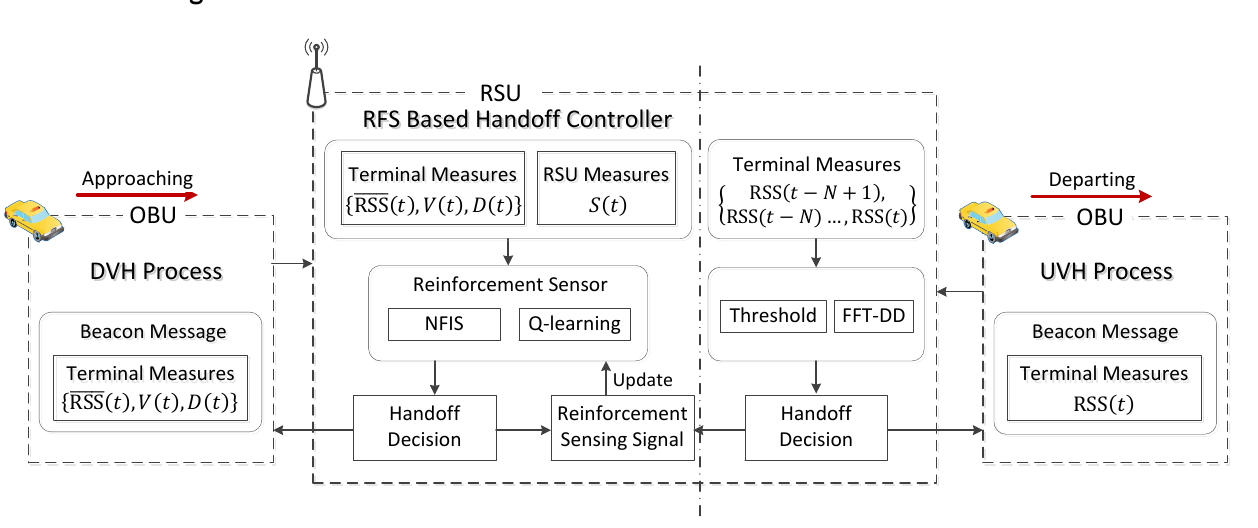
Figure 2. The architecture of the RFS embedded vertical handoff controller.